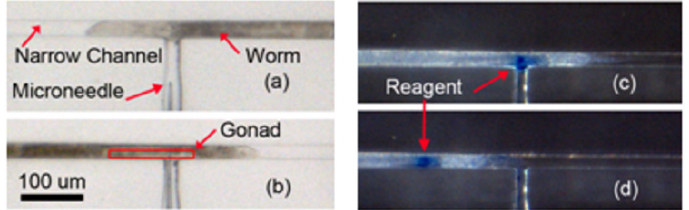
Figure 14. The sequence of four steps for microinjection: ( a ) loading and immobilization, ( b ) needle penetration, ( c ) reagent injection and ( d ) unloading.